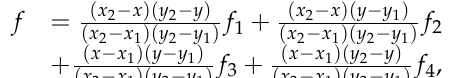
Figure 5. Schematic diagram of bi-linear interpolation.